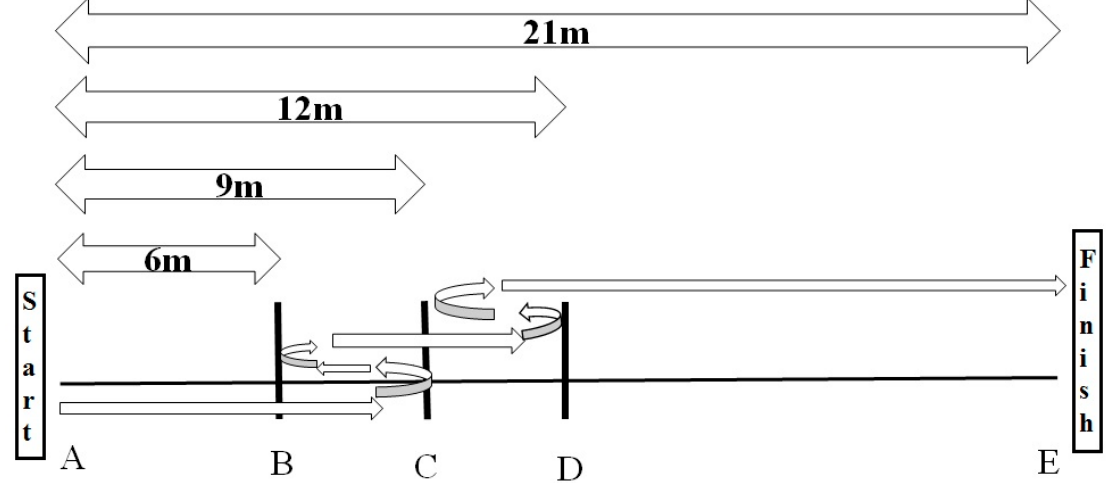
Figure 2. Design of the sprint 9–3–6–3–9 m with 180° turns (S180°) or with backward and forward running (SBF). A and E are start and finish lines respectively. B, C and D are lines of change of direction. Sprint 4 × 5 m (S4 × 5